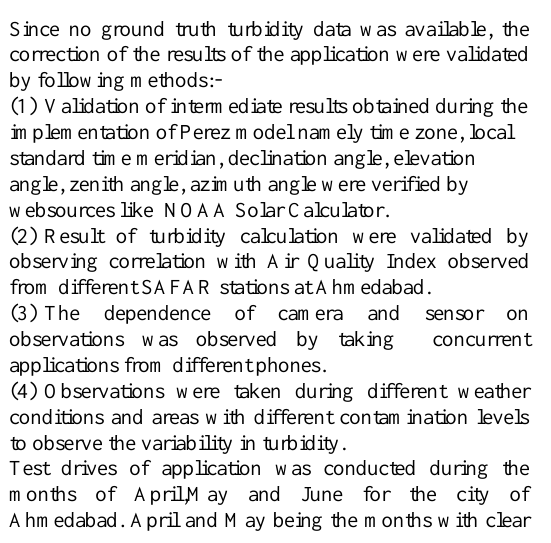
Figure 10: Comparative plot of Azimuth angle